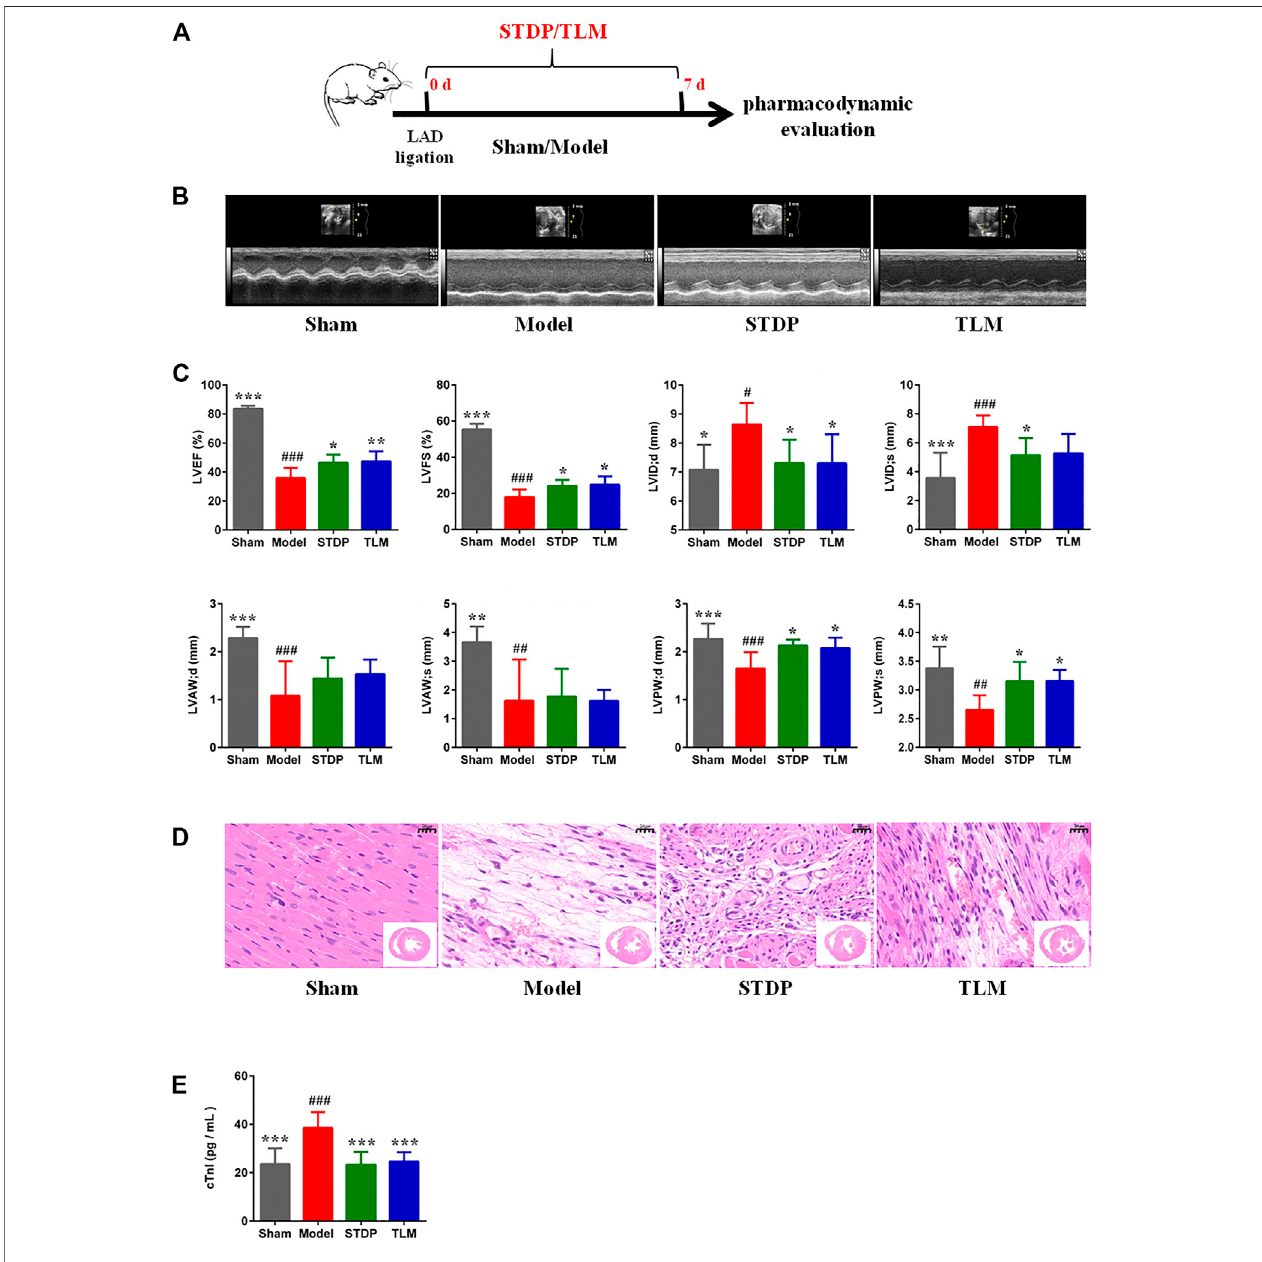
FIGURE1| Effects ofShexiangTongxin droppingpills(STDPs) on cardiac function. (A) Theexperimental protocol forSTDP study inleft anterior descending (LAD) ligationinducedthecoronarymicrovasculardysfunction(CMD)modelrats. (B) Representativeimagesofechocardiographyinthesham,model,STDP,andTLMgroups. (C) Echocardiographic parameter analysis in different groups. N = 6 per group. (D) Representative H and E staining of paraf fi n sections. Scale bar = 20 μ m. (E) The serum troponin (cTnI) in different groups. N = 6 per group. * p < 0.05, ** p < 0.01, *** p < 0.001 vs . the model group; # p < 0.05, # # p < 0.01, # # # p < 0.001 vs . the sham